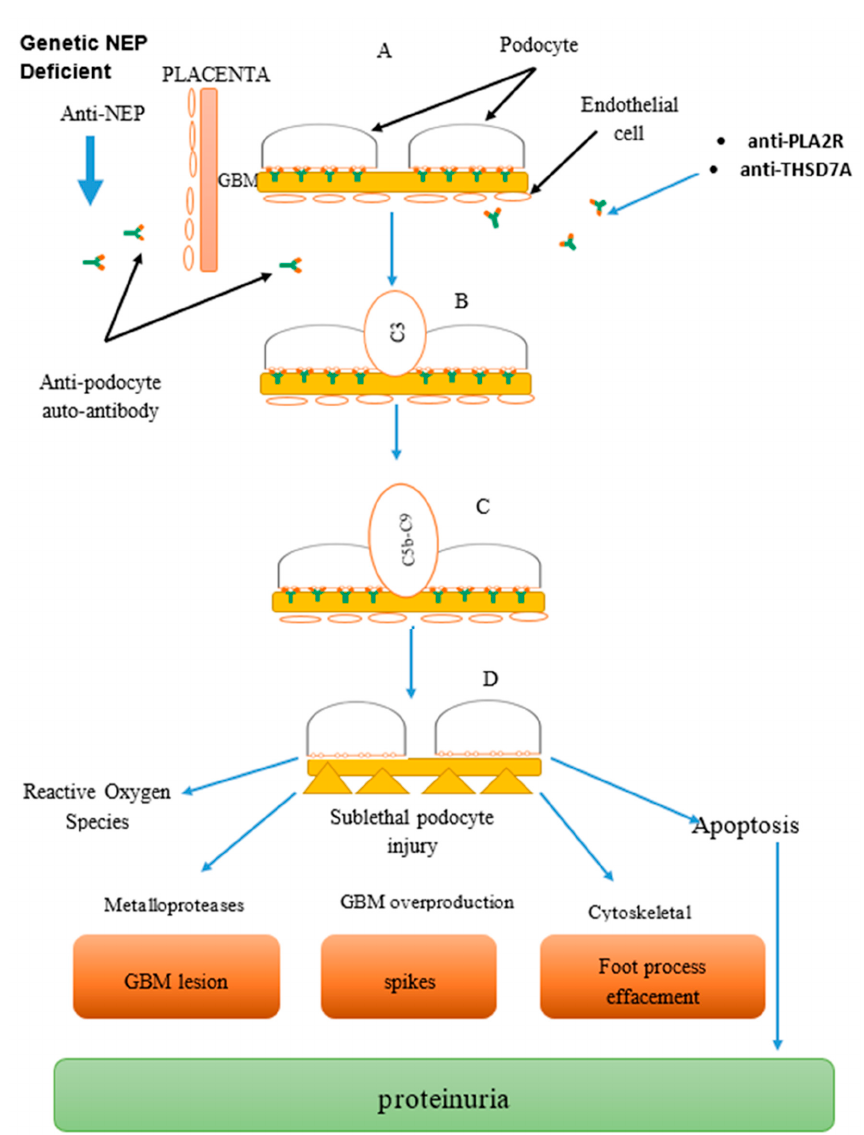
Figure 1. Combined image: Mechanism of anti-podocyte (anti-neutral endopeptidase (NEP), anti-phospholipase A2 receptor (PLA 2 R), anti-thrombospondin domain containing 7A (THSD7A)) antibody-mediated disease in membranous glomerulonephritis (MGN), part of glomerular basement membrane (GBM). Formation of complexes: ( A ) Antigen–antibody reacts to form complexes at the podocyte. ( B ) Complement activation system via the classical and alternative pathway. ( C ) Formation of complement membrane attack complex leading to cell injury. ( D ) Podocyte injury leading to proteinuria and cell